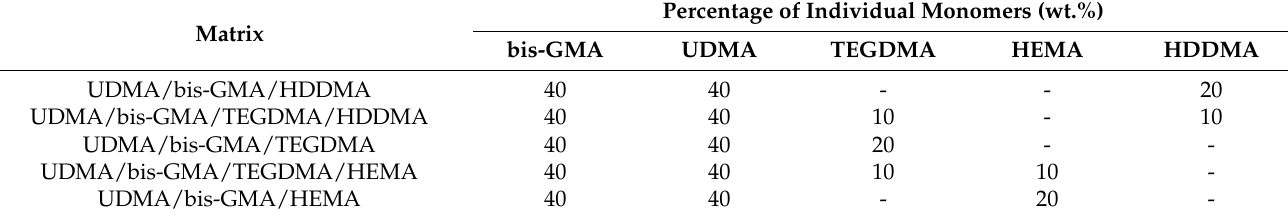
Table 1. Composition of matrices. Composites used in this study have the same resin composition and contain 45 wt.% of silanized